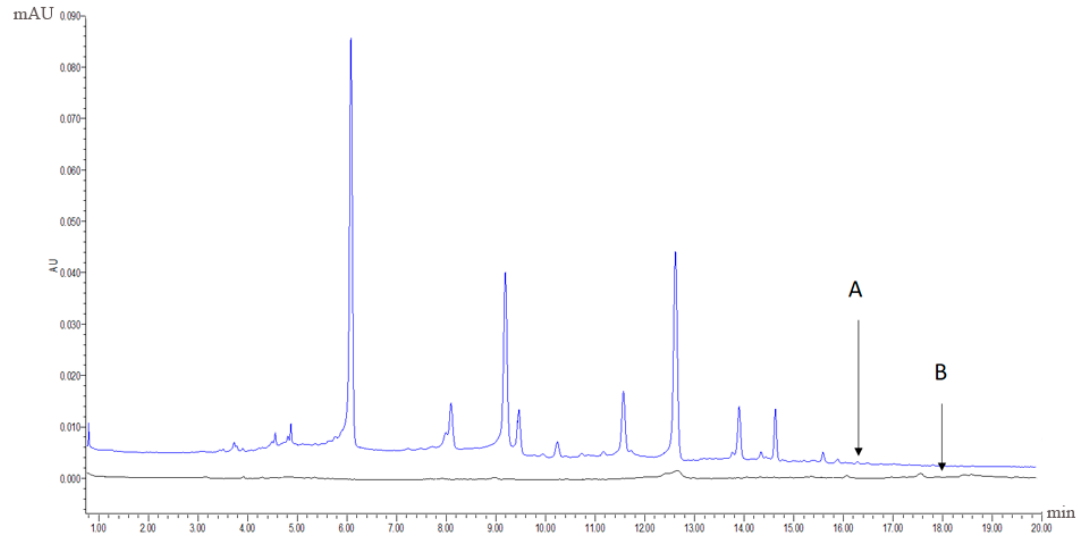
Figure 6. (A) the chromatographic fingerprint of Sample 1 (R1) and (B) the antioxidant activity fingerprint of Sample 1 (R1) after the DPPH free radical scavenging reaction detected at 330 nm,